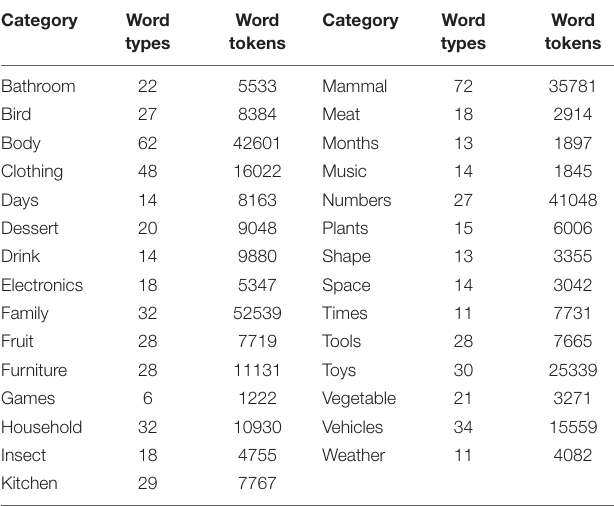
TABLE 2 | The set of categories, the number of word types in each category, and the number of occurrences of word types in each category in the training corpus.